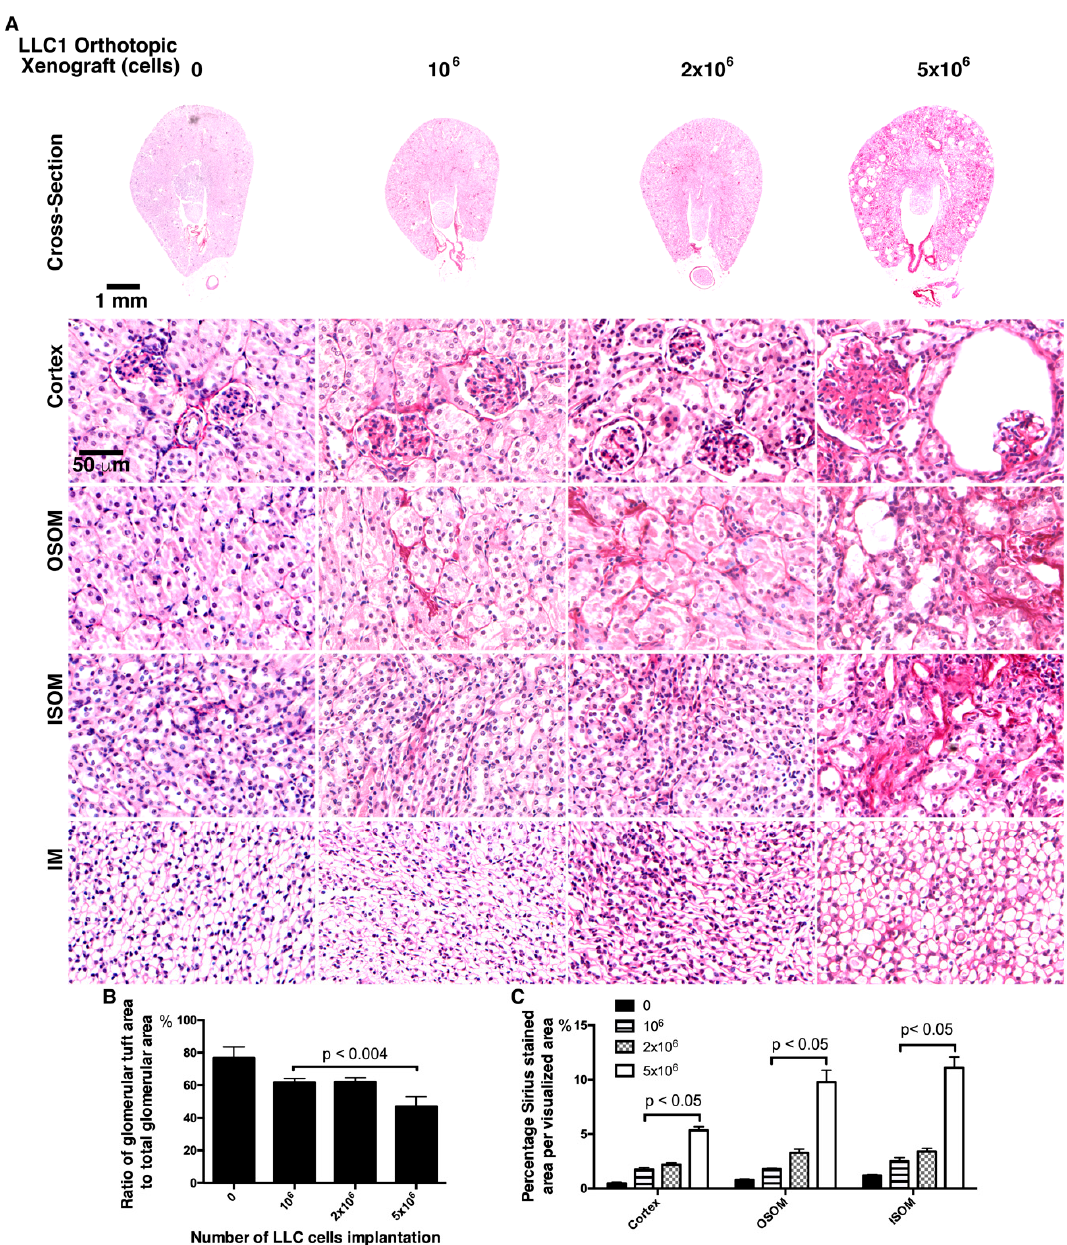
Figure 5. Renal fibrosis in the kidneys of lung cancer mice. ( A ) Renal fibrosis was detected in mice transplanted with different numbers of LLC1 cells by Sirius red staining. The Sirius red-labeled collagen protein was used to assess the grade of renal fibrosis. Few Sirius red signals were detected in the kidney without LLC1 xenografts. There were slightly more Sirius red-stained collagen proteins in the cortex, outer stripe of the outer medulla (OSOM), and inner stripe of the outer medulla (ISOM) in the kidneys of mice with 1 × 10 6 and 2 × 10 6 LLC1 cells. Severe renal fibrosis was noted in the cortex, OSOM, and ISOM in the kidneys of mice with 5 × 10 6 LLC1 cells (bar = 50 μ m). ( B ) Glomerular impairment was represented as a lower ratio of glomerular tufts to total glomerulus (bar chart of the ratio of glomerular tufts to total glomerulus). ( C ) The Sirius red-stained area was measured, which showed severe renal fibrosis.